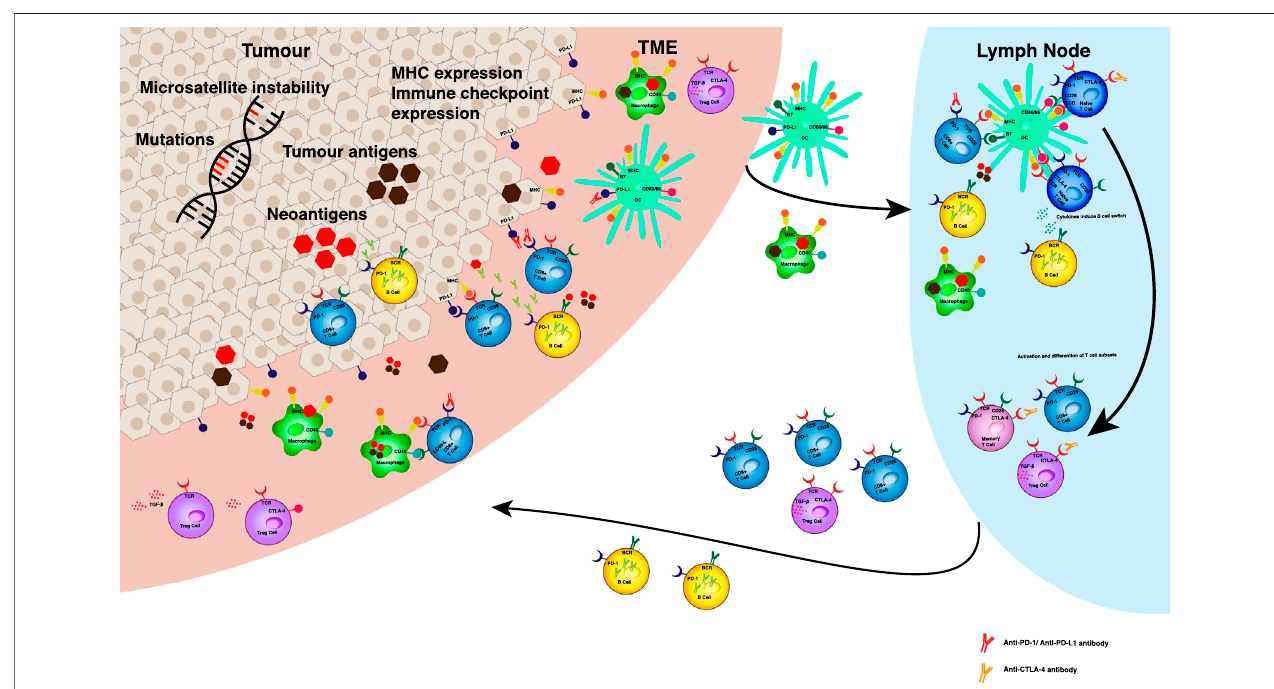
FIGURE 1 | Predictive biomarkers for ICB ef fi cacy. Tumour intrinsic factors such as genetic instability and mutational load can increase the production of tumour neoantigens in the TME. Antigen is taken up by APCs in the TME. MHC expression on tumour cells, macrophages and dendritic cells can effect antigen presentation to resident T cells and in local lymph nodes. The presence of upregulated immune checkpoints, such as PD-1, PD-L1, CTLA-4 can result in inhibitory signalling to prevent effectiveactivationanddifferentiation ofimmunecellsusbsetsintheTMEandlymphnode.Levelsofexpressionofthesereceptorsand theirligandsmaydeterminethe impact ofrespective monoclonal antibodytreatmentson anti-tumour responses. The balance ofT cellsubsets and B cells determinesthe immune suppressed or activated status of the anti-tumour immune response. Anti-PD-1 antibodies act in the tumour microenvironment (TME) by disrupting the negative regulation of anti-tumour immunity mediated by PD-1 and its ligands (PD-L1 and PD-L2) expressed on somatic cell types and antigen presenting cells (APCs) respectively. Upon exposure to tumour antigen, tumourin fi ltratinglymphocytesexpressPD-1andreleasepro-in fl ammatorycytokines,suchasinterferon- γ ,whichtriggerPD-L1expressionincellsintheTME.PD-1/PD-L1